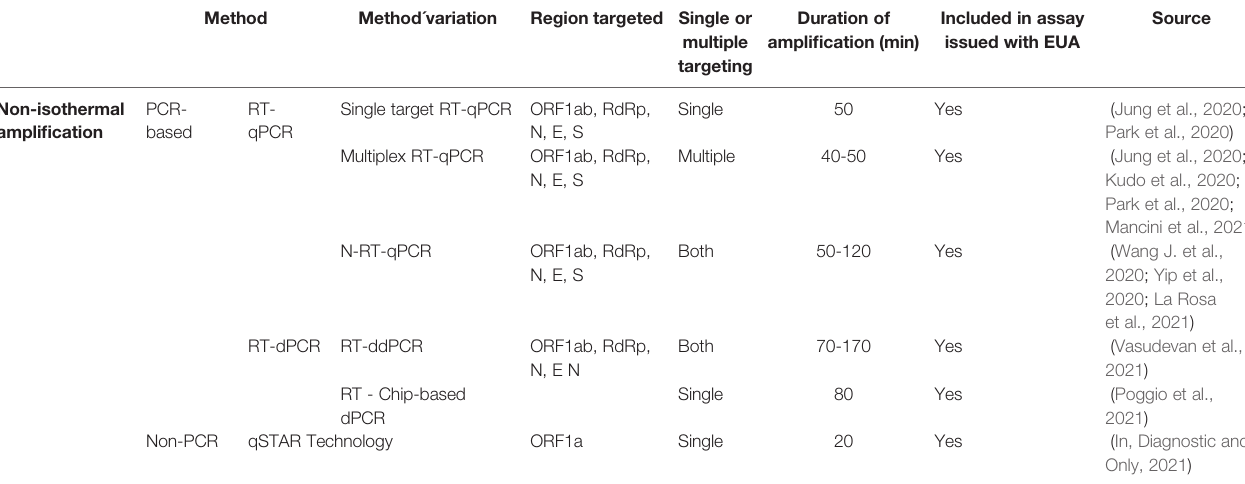
TABLE 3 | Compilation of strategies of non-isothermal ampli fi cation explored for SARS-CoV-2